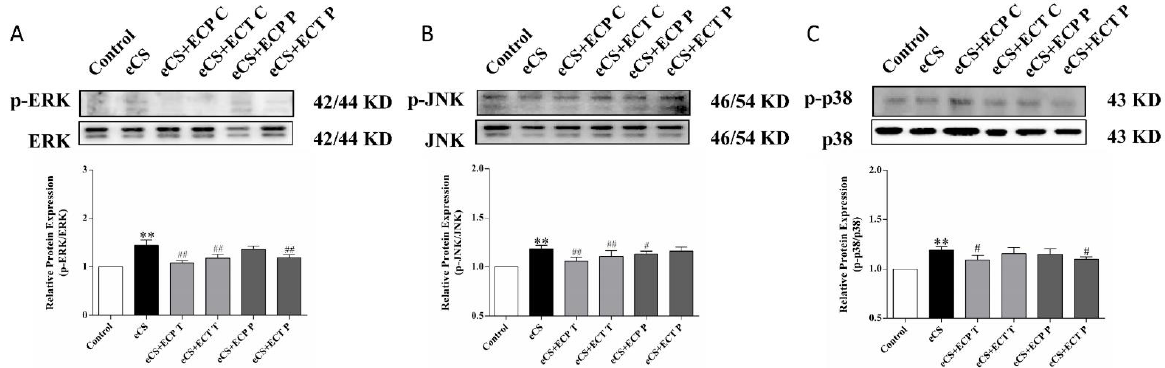
Figure 7. The effects of ECP and ECT on the expression of the p38, p-p38, JNK, p-JNK, ERK and p-ERK proteins in the lung of mice exposed to eCS. Western blot analysis for the expression of phosphorylated ( A ) p-ERK and total ERK, ( B ) p-JNK and total JNK, ( C ) p-p38 and total p38 in lung tissues of mice induced by eCS. The measures represent mean ± SD. **: compared with the blank control group, p < 0.01; #: compared with the eCS model group, p < 0.05; ##: compared with the eCS model group, p < 0.01.